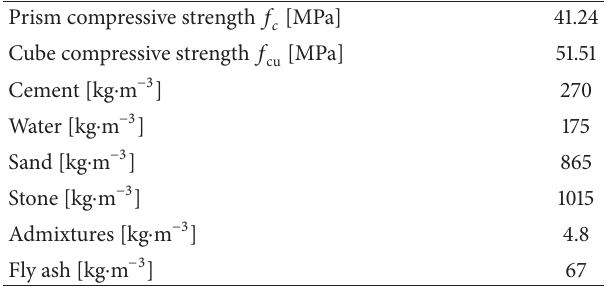
Table 3: Mechanical properties and mixture ratio of concrete. Prism compressive strength 𝑓 𝑐